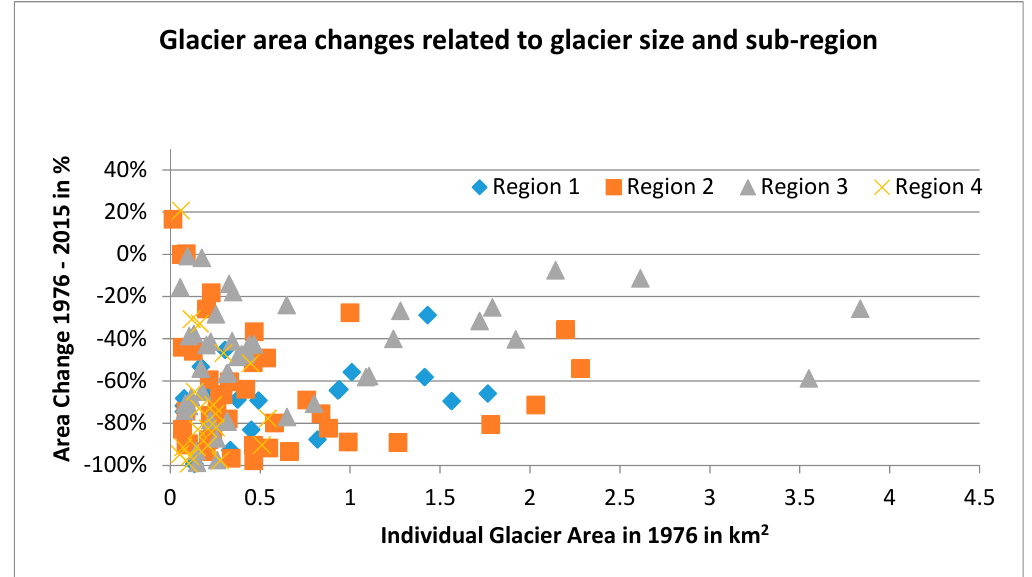
Figure 4. Relative glacier area changes between 1976 and 2015 plotted against the individual glacier area in 1976.